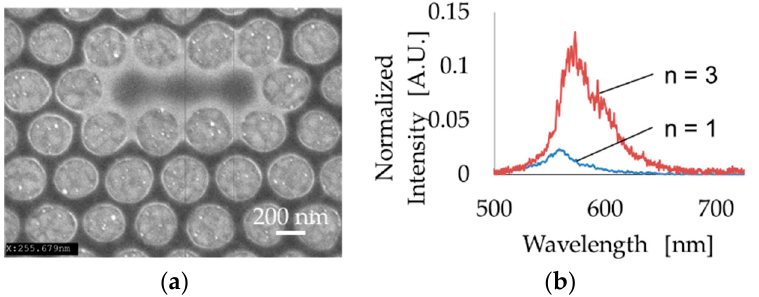
Figure 6. ( a ) Fabrication of the three-defect PhC resonator and waveguide. ( b ) Comparison of intensity with one and three defects. Micromachines 2018 , 9 , x 7 of 9